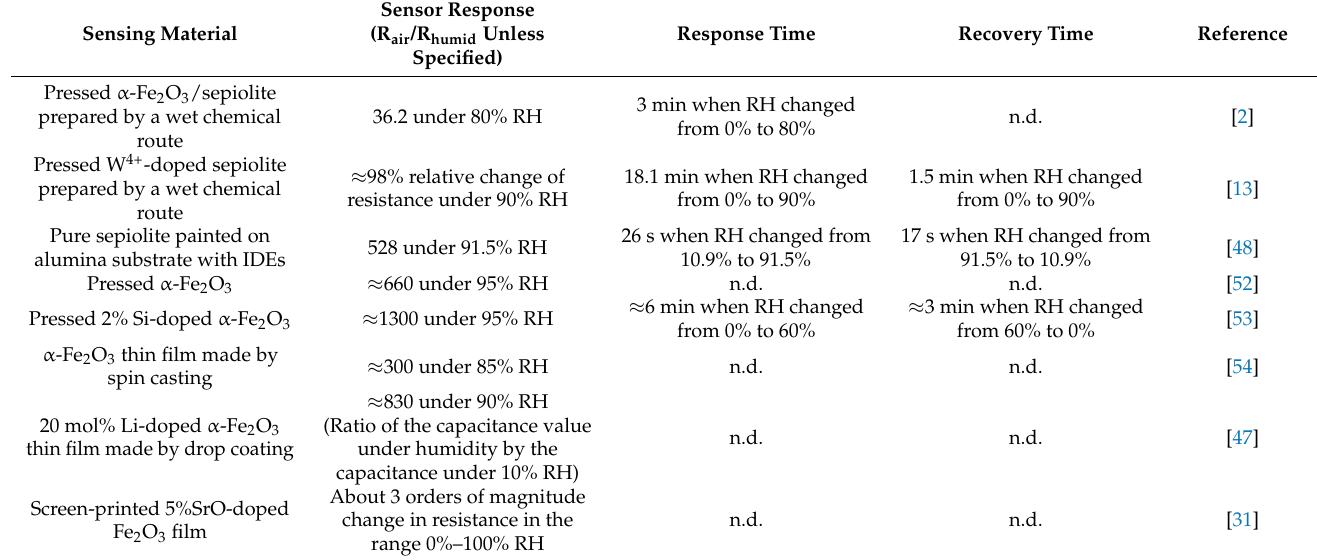
Table 6. Comparison of the synthetic sepiolite sensor’s performance with literature data regarding sensors based on sepiolite and iron oxide operating at room temperature (unless